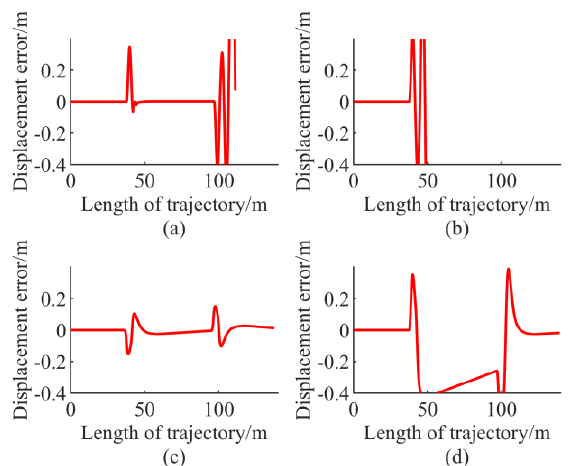
Figure 15. The heading angle speed when velocity is 4 m/s. ( a ) LMPC. ( b ) LEMPC. ( c ) NMPC. ( d ) NEMPC.